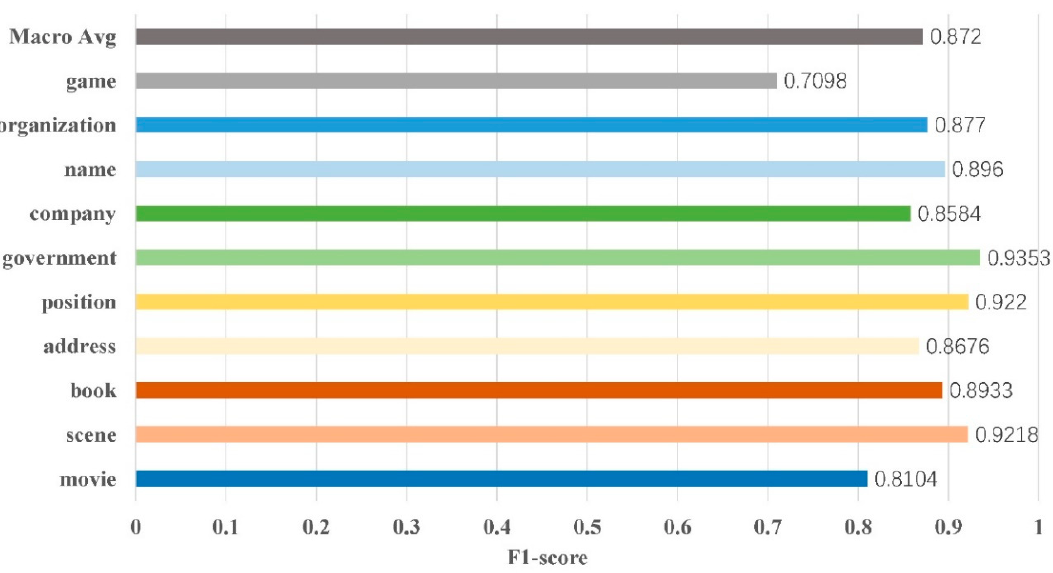
Figure 6. Statistical recognition results on the People's Daily Ner Corpus. Involving all ten named entities on CLUENER2020, our method is very sensitive in identifying “scene”, “government”, and “position”. However, the performance in identifying “game” is not as sensitive as other entities. We suspect that the name of many games is often random and irregular, so it is more challenging to recognize. The test results on the People's Daily Ner Corpus show that the recognition of “person” is relatively more sensitive than the recognition of “location” and “organization”. This may be related to the distribution and number of samples for each entity type. 6. Conclusions In this paper, an innovative deep neural network model is proposed for Chinese named entity recognition tasks. This model named En2BiLSTM-CRF provides a new idea for researchers to solve